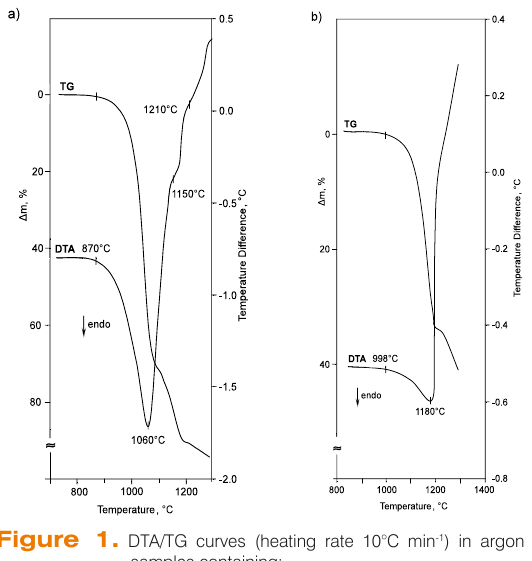
Figure 1. DTA/TG curves (heating rate 10°C min -1 ) in argon of samples